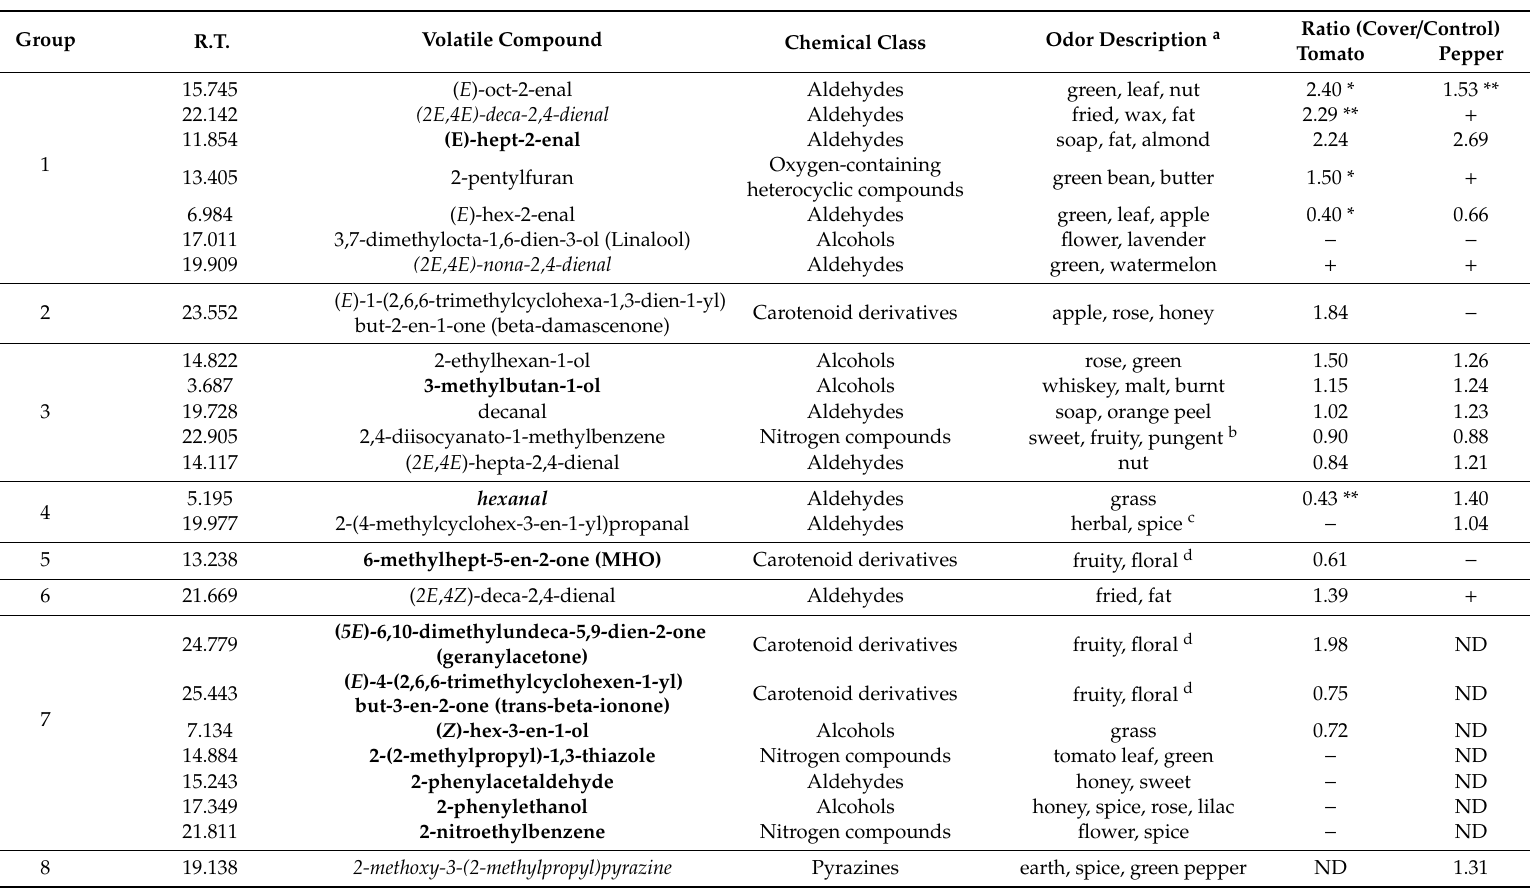
Table 3. Volatile compounds detected in ripe tomato and pepper fruits under normal and canopy conditions. The data represents the mean of the ratio (canopy / control) for three biological